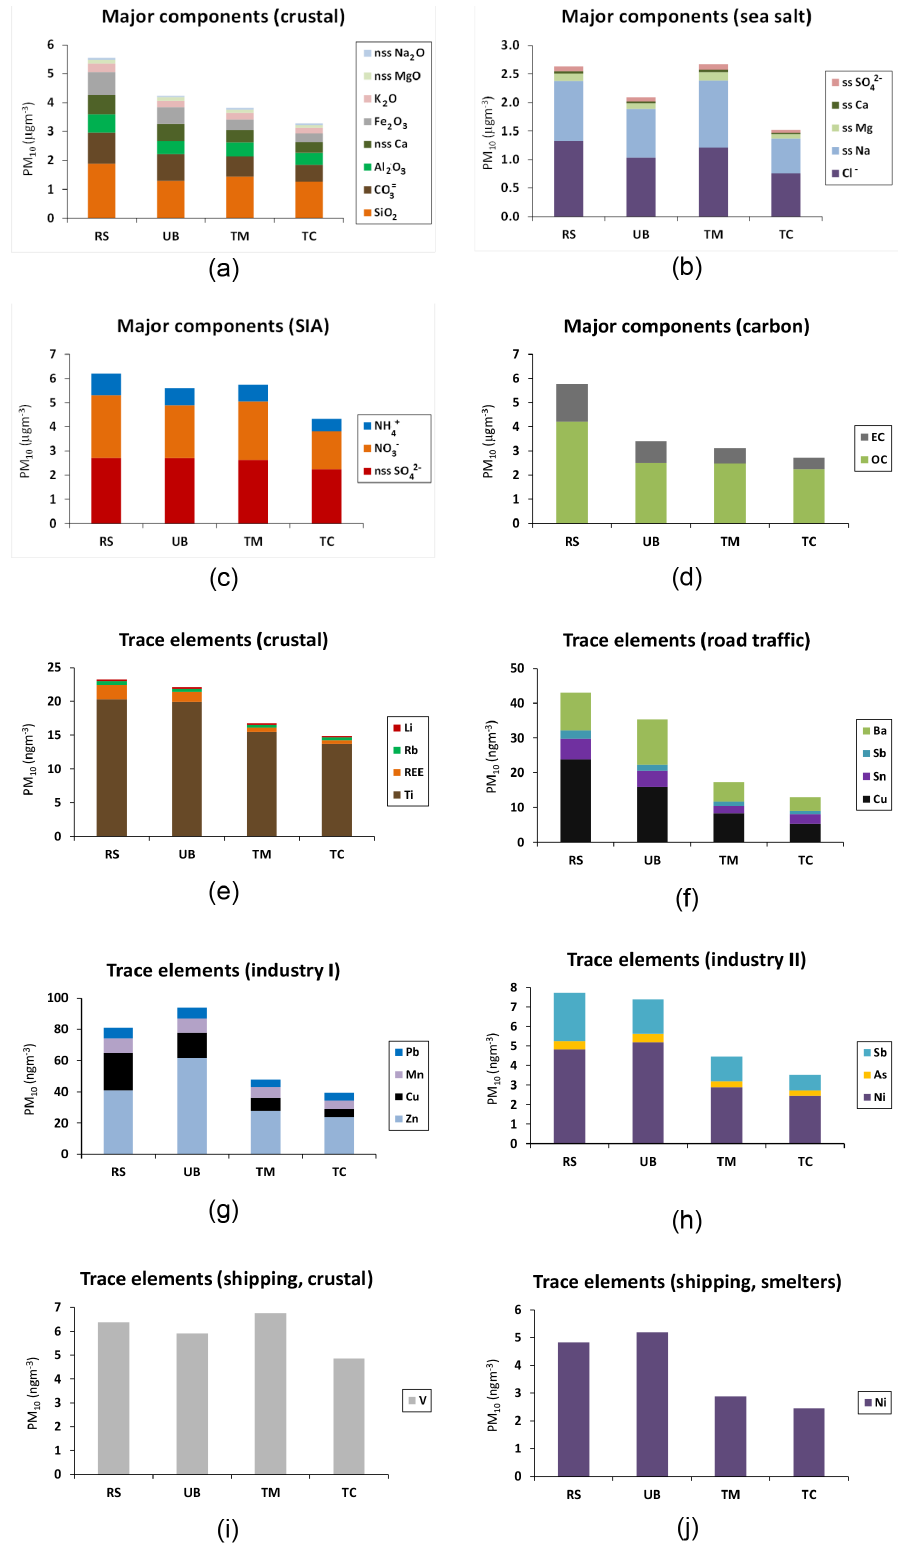
Figure 3. Average PM 10 concentration of main and trace elements for different emission sources at each site (RS: Road Site, UB: Urban Background, TM: Torre Mapfre, TC: Torre Collserola). REE denote rare earth